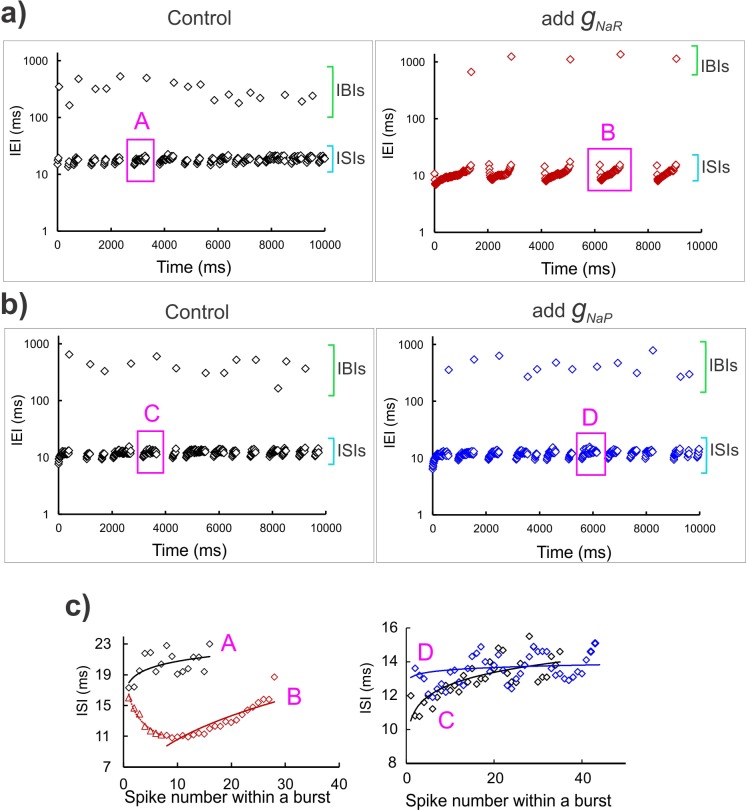
Spike timing regularity monitored by INaR.a, b) Time series graphs showing inter-event intervals (IEIs) under control condition (left panels in both a, b), and dynamic-clamp addition of gNaR (right panel in a), and gNaP (right panel in b). The green and cyan square brackets in each panel highlight the IBI and ISI range respectively. The y-axis shows IEIs on a log scale. Magenta boxes demarcate a representative burst in each case, which is expanded in the graphs in c), corresponding with the bold letters, A, B, C and D. The solid lines in (c) are power regression fit in each case; in all the panels, black open diamonds are control, maroon open diamonds correspond with gNaR application and blue open diamonds correspond with the gNaP application.